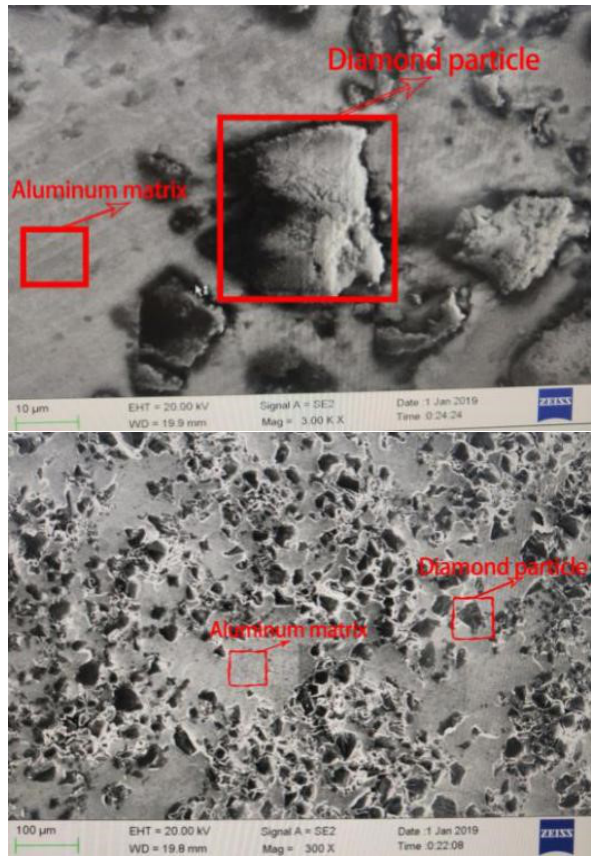
Figure 1: The composition schematic diagram of the material